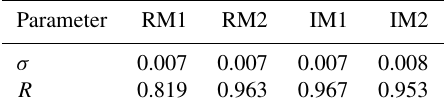
Table 2. Estimates of the applicability of different methods (RM1, RM2, IM1 and IM2) of the τ c (or τ f ) calculation. 0 . 5 Parameter RM1 RM2 IM1 IM2 σ 0.007 0.007 0.007 0.008 R 0.819 0.963 0.967